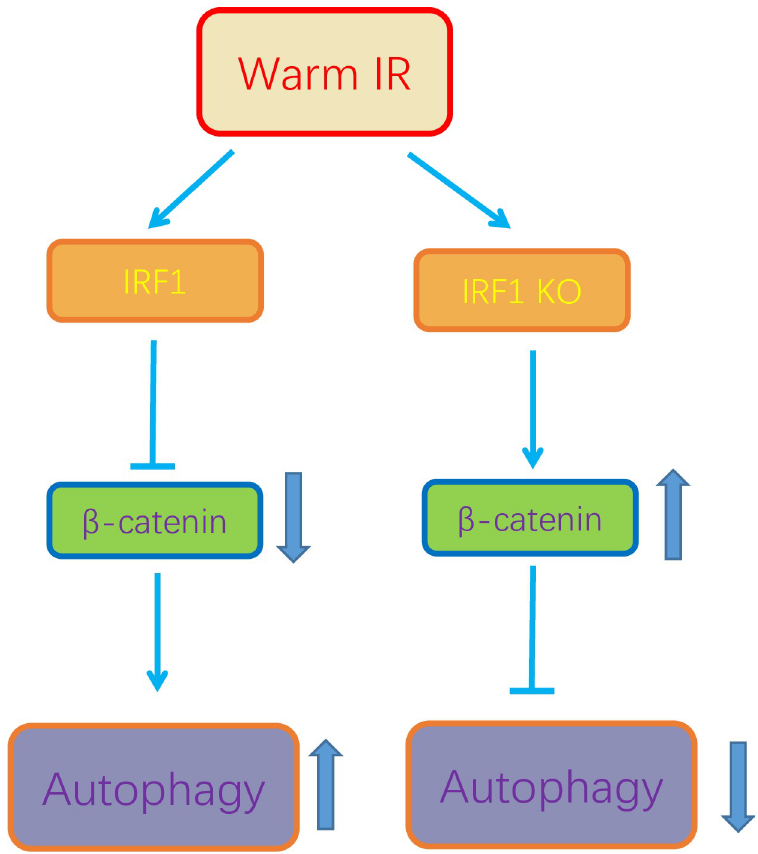
Fig 8. IRF1 activates autophagy to promote liver IR injury by inhibiting β -catenin. IRF1 is induced in hepatic IR and inhibits β -catenin and is associated with increased autophagy. In IRF1 KO mice, β -catenin expression is increased and is associated with decreased autophagy and less liver